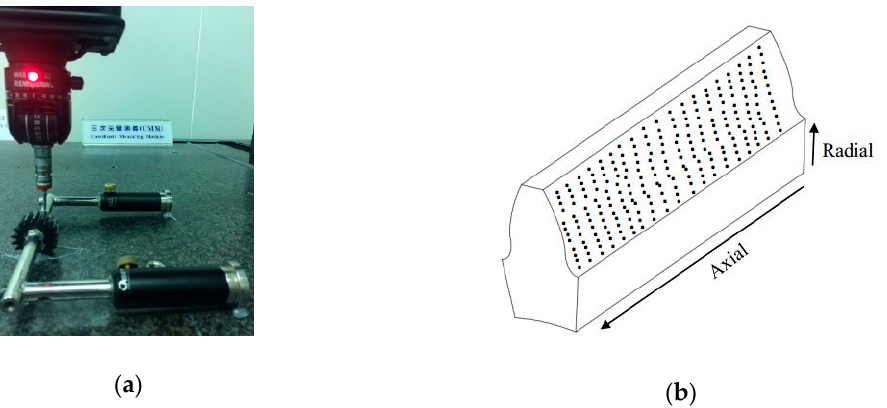
Figure 9. ( a ) Tooth surface measured by a commercial coordinate measuring machine (CMM); ( b ) measuring points on the tooth surface.